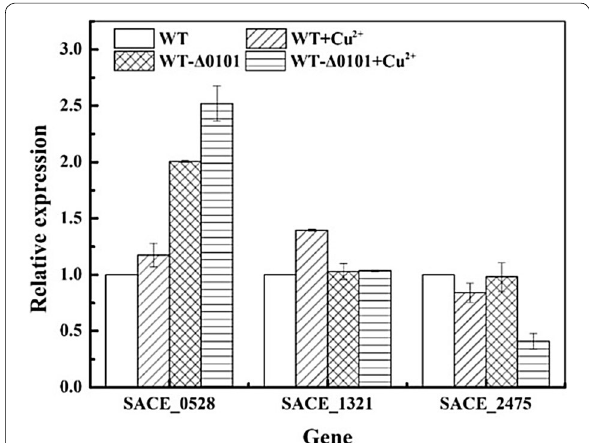
Fig. 6 Evaluation of the transcript levels of three genes SACE_0528, SACE_1321, and SACE_2475 by RT-qPCR of the control strain WT (white square), WT cultured with 0.4 mmol/L Cu 2 + (square with upper right to lower left fill), WT-Δ0101 (square with diagonal crosshatch fill), and WT-Δ0101 cultured with 0.4 mmol/L Cu 2 + (square with horizontal fill). Genes expression in each sample were calculated as the fold expression ratio after normalization to the 16srRNA transcript as a reference control. The values are averages of three independent RT-qPCR experiments; error bars indicate standard